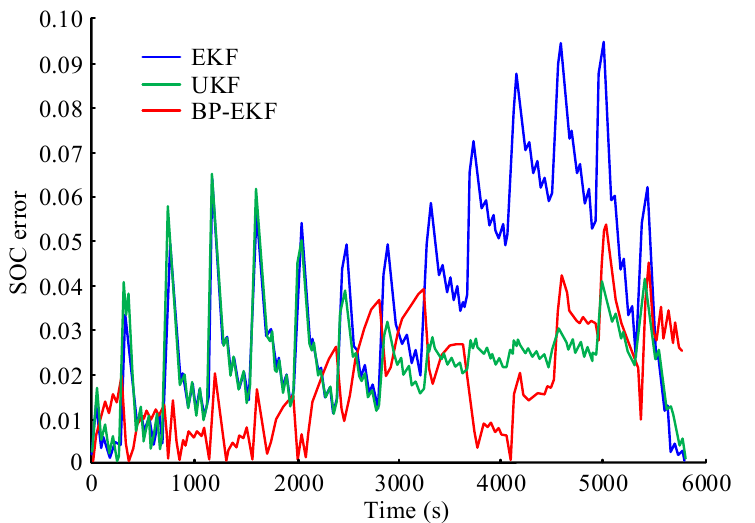
Figure 8. Absolute value curve of E-cell SOC estimation error of three models under DST operating mode.